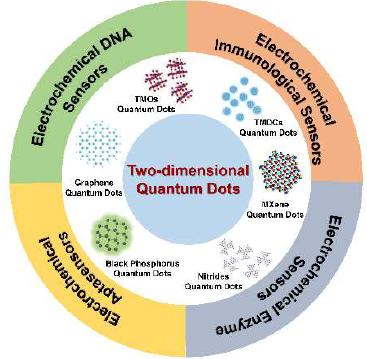
Figure 1. Schematic diagram of 2D-QD-based electrochemical biosensors.